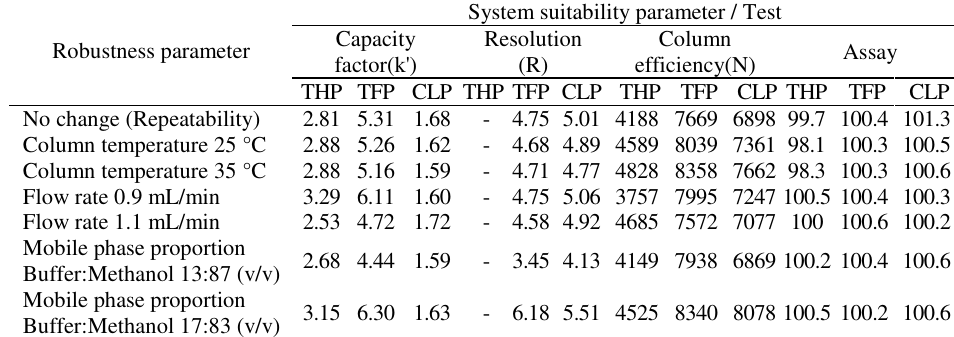
Table 6. Robustness impact of system suitability parameter and assay value